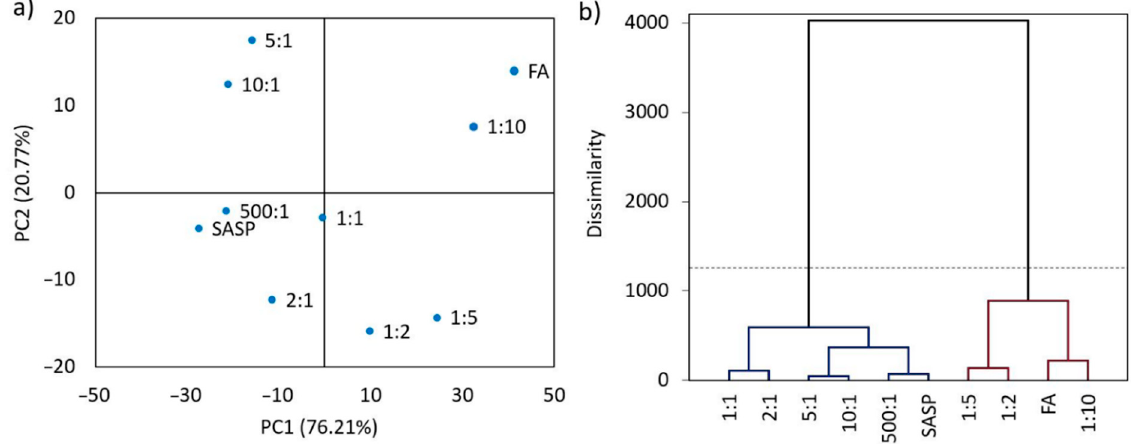
Figure 5. Results of the statistical analysis showing ( a ) the principle component analysis (PCA) bidimensional scatterplot and ( b ) cluster analysis (CA) dendrogram, indicating similarities between SASP, FA and their blends.